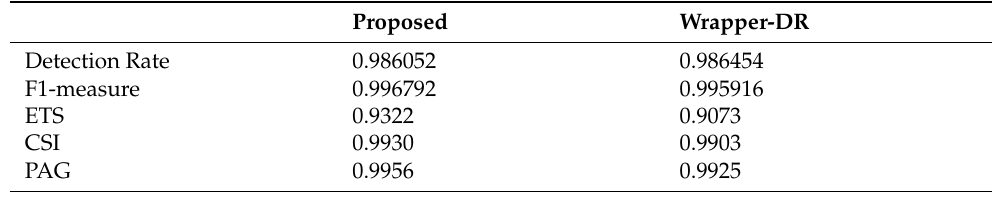
Table 6. Result of binary decoding: table.